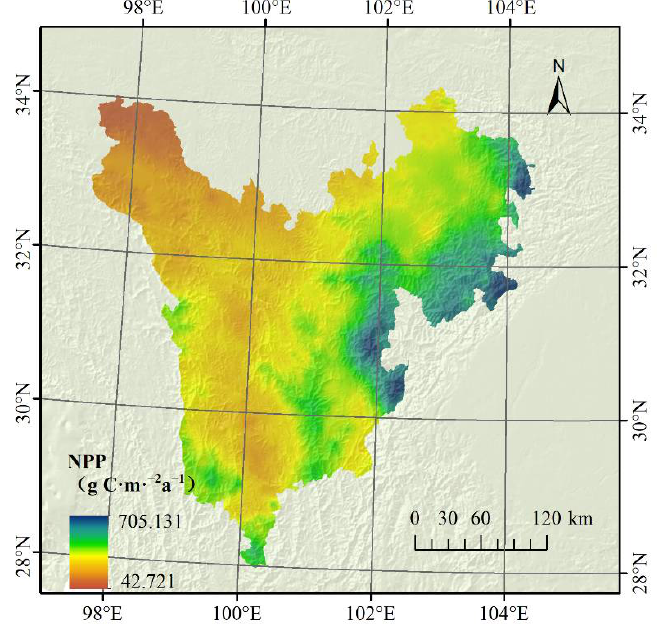
Figure 6. Spatial distribution of annual average NPP from 2000−2016.